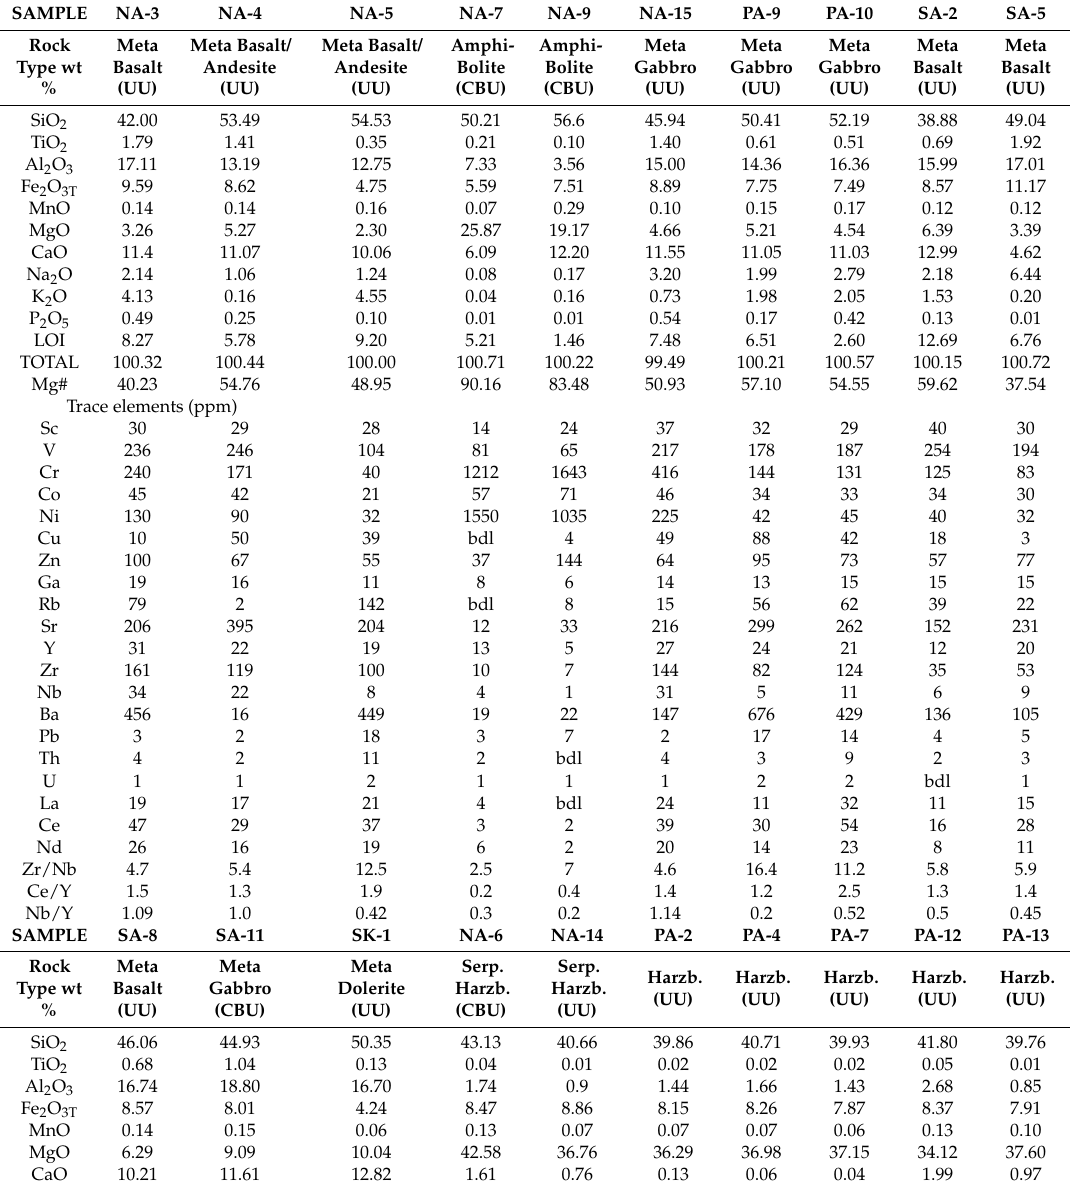
Table 1. Whole-rock major and trace element compositions of metabasites and ultramafic rocks from the Aegean